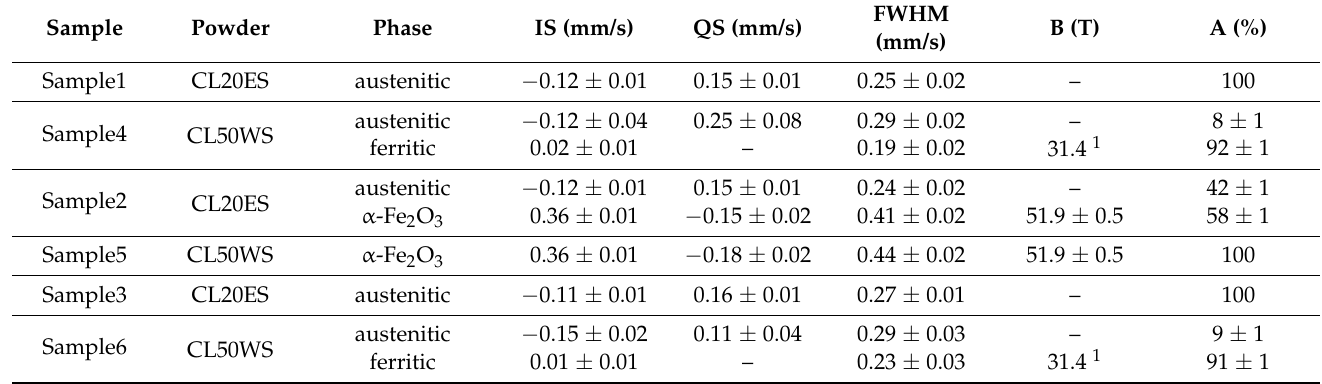
Table 3. Parameters of CEMS.